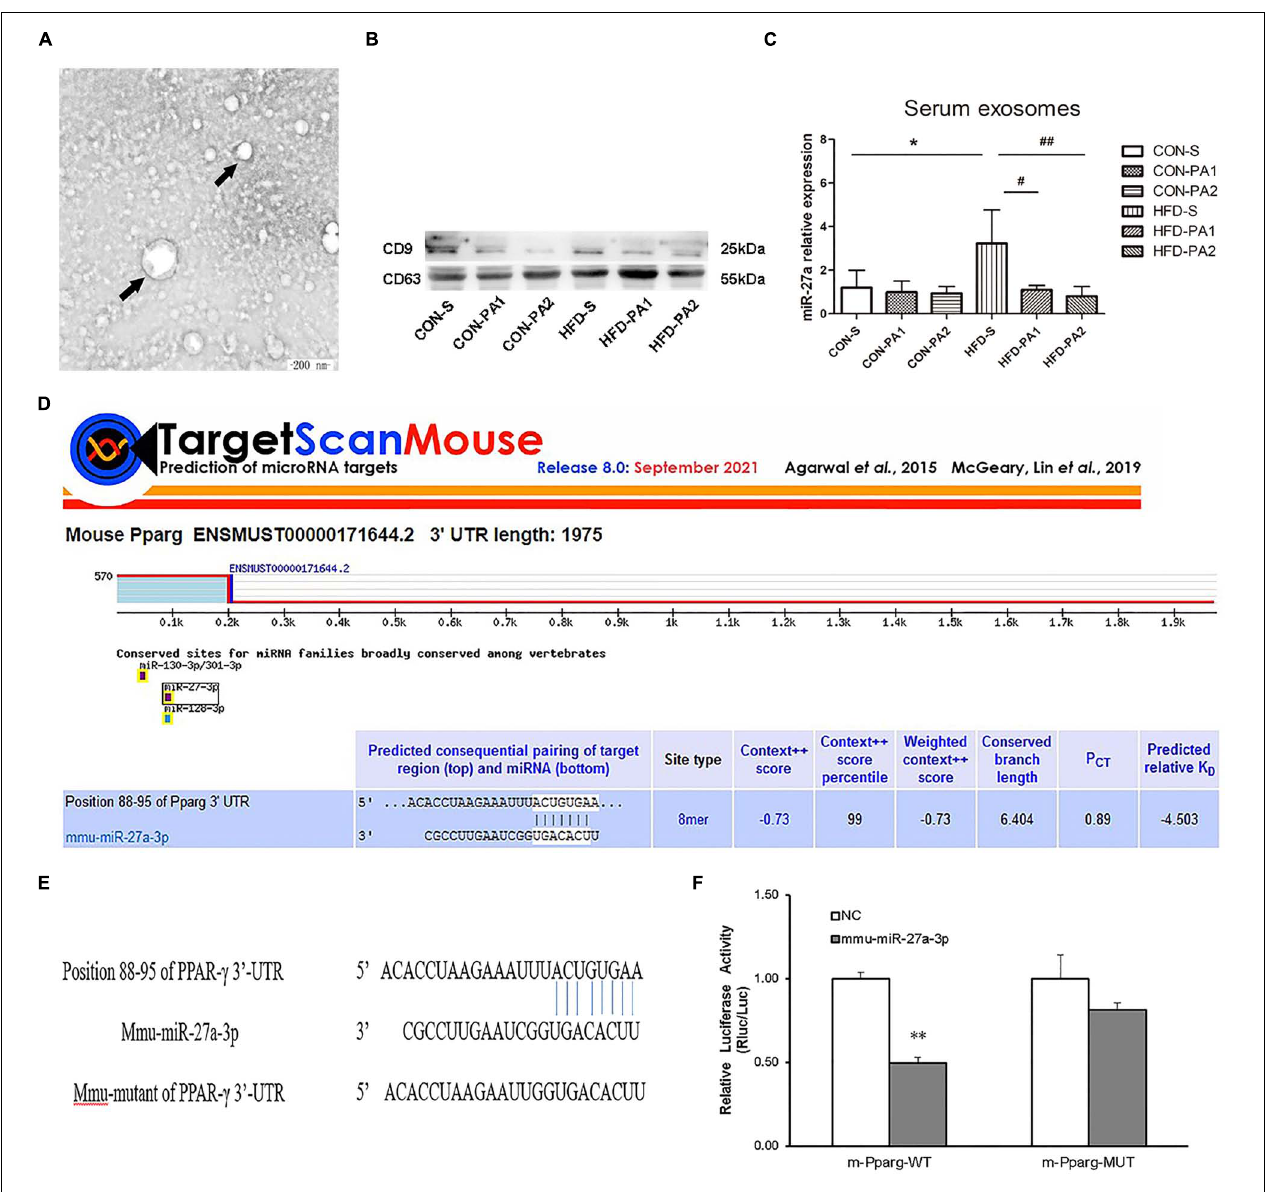
FIGURE 4 | Serum exosome miR-27a level and target gene prediction. (A) TEM demonstrated that exosomes secreted by mice were round vesicles (bars = 200 nm). (B) Western blot detected the protein expressions of CD9 and CD63 in exosomes. (C) Expressions of exosomes miR-27a were measured by qRT-PCR. (D) Prediction of the target gene of miR-27a. (E) Schematic of the miR-27abinding site to PPAR- γ 3 (cid:48) -UTR. (F) Luciferase reporter assay indicated the binding of miR-27a with PPAR- γ . Compared with the CON-S group, ∗ P < 0.05 and ∗∗ P < 0.01; compared with the HFD-S group, # P < 0.05 and ## P < 0.01; comparison between exercise groups (CON-PA1 vs. CON-PA2, HFD-PA1 vs.